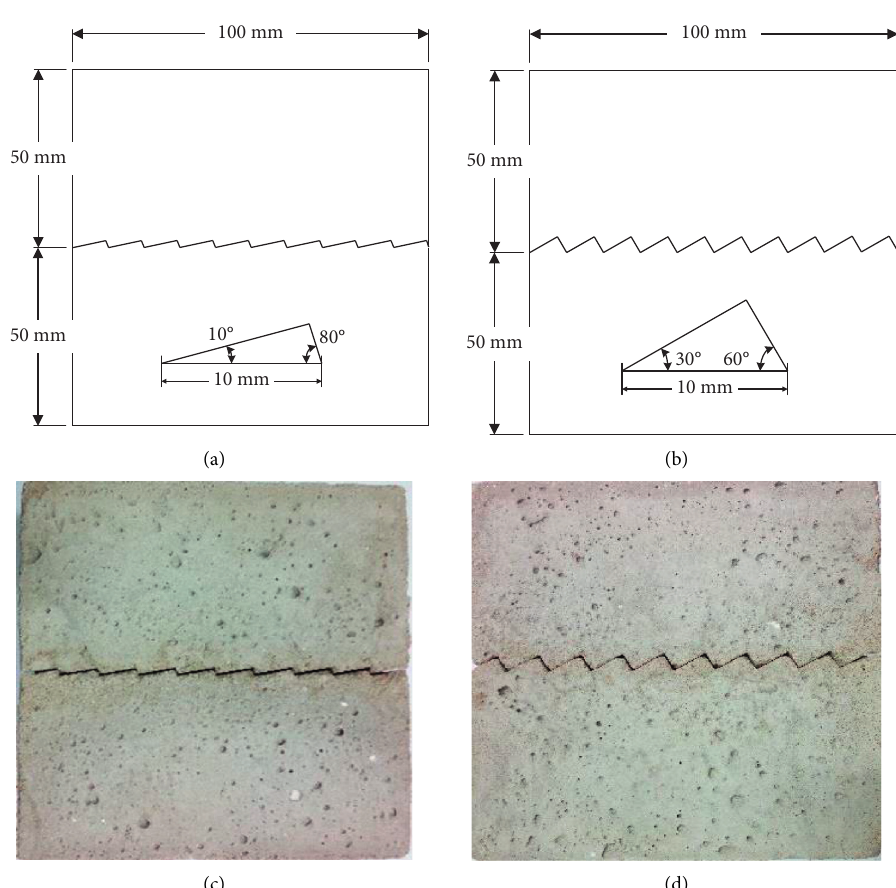
Figure 2: Ichnography of the dentate discontinuities and the sample preparation method: (a) section size of the 10 ° structural planes; (b) section size of the 30 ° structural planes; (c) sample with a slope angle of 10 ° ; (d) sample with a slope angle of 30 °